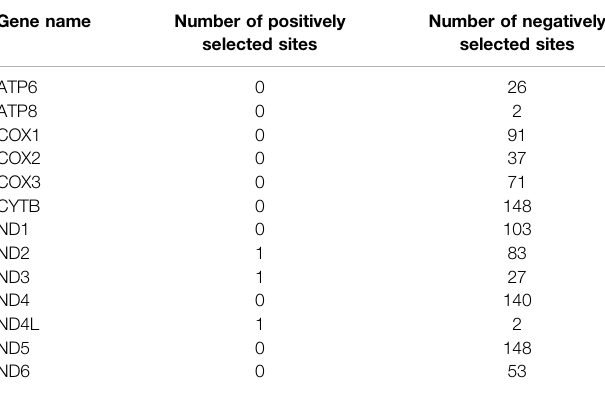
TABLE 2 | Statistics of positively selected sites and negatively selected sites derived from the FEL ( fi xed effects likelihood)